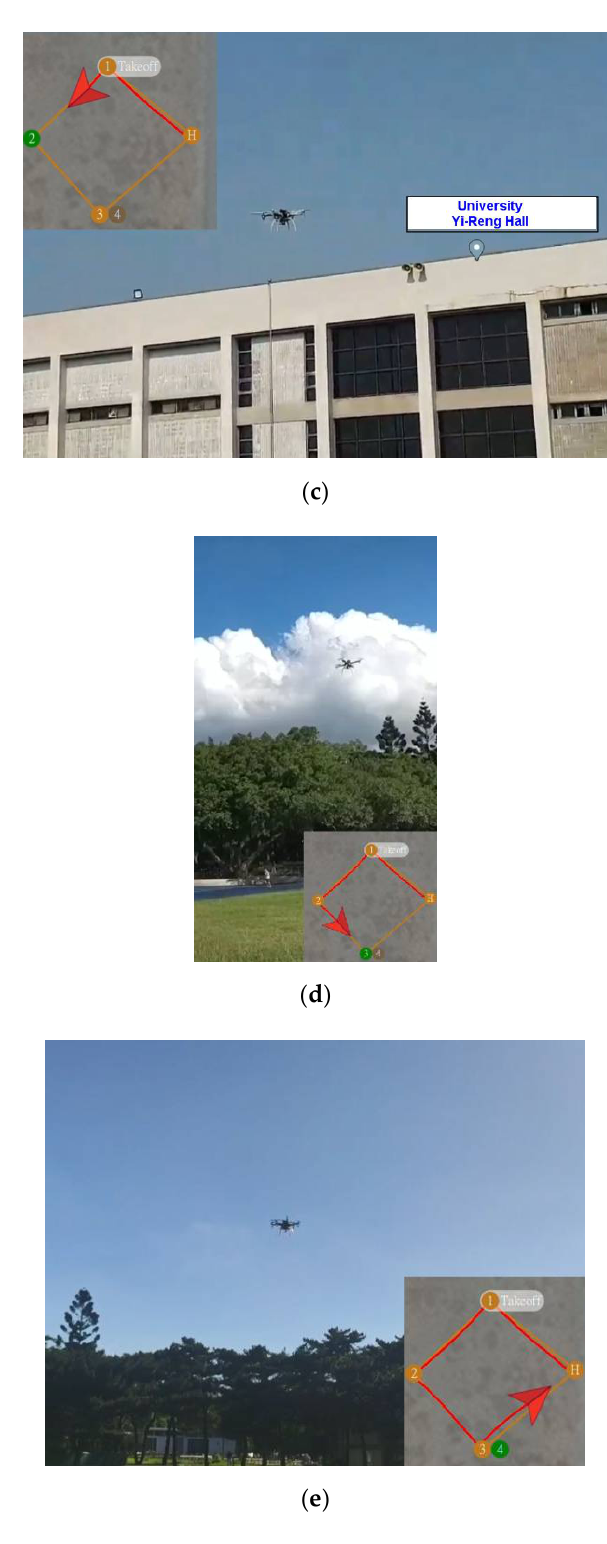
Figure 10. ( a – e ) Trajectory tracking processes of quadrotor in